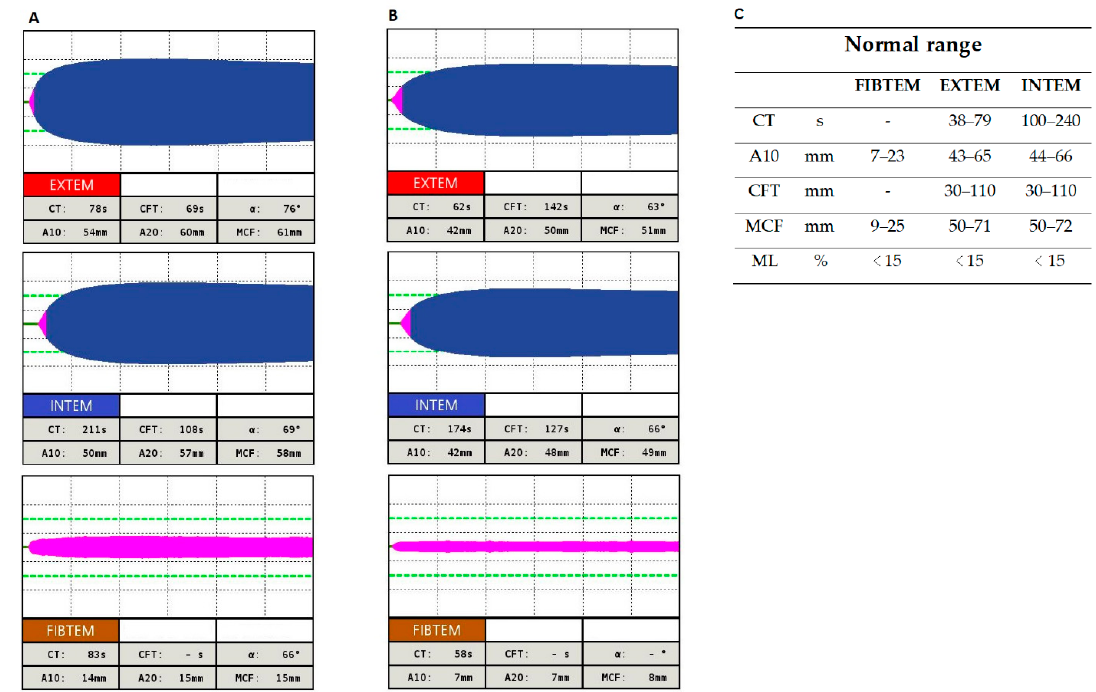
Figure 1. Rotational thromboelastometry EXTEM (extrinsically activated thromboelastometric test), INTEM (intrinsically activated thromboelastometric test) and FIBTEM (extrinsically activated thromboelastometric test) for patient 1 ( A ), patient 2 ( B ) and normal range: EXTEM, INTEM and